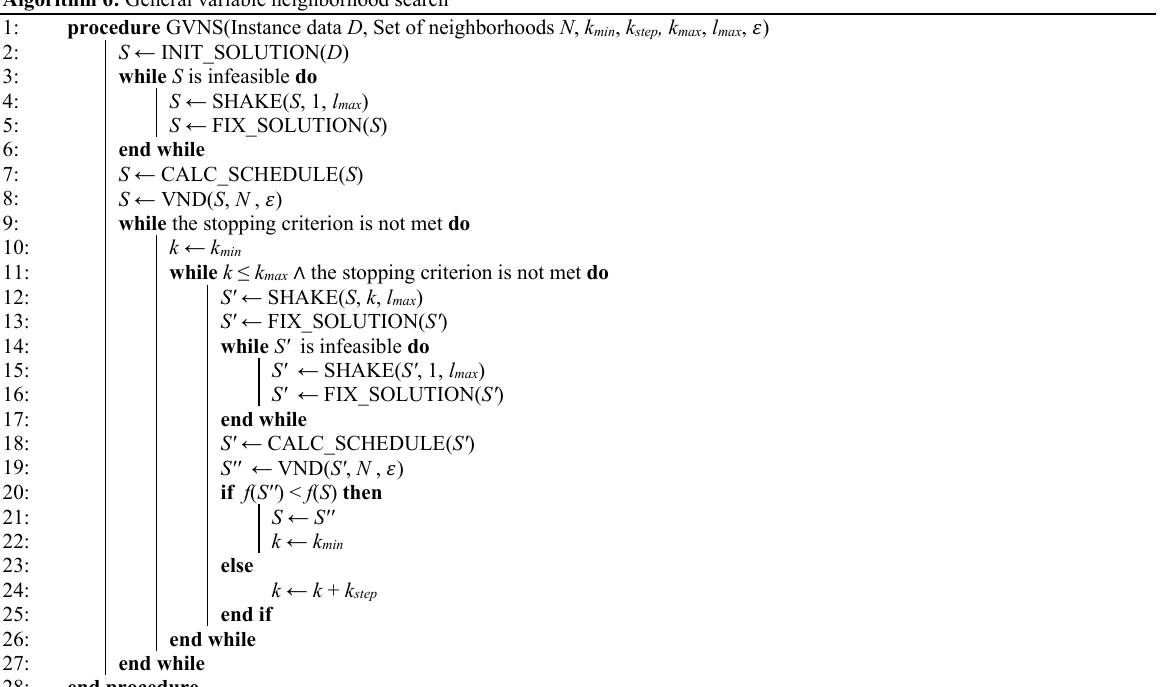
Algorithm 6: General variable neighborhood